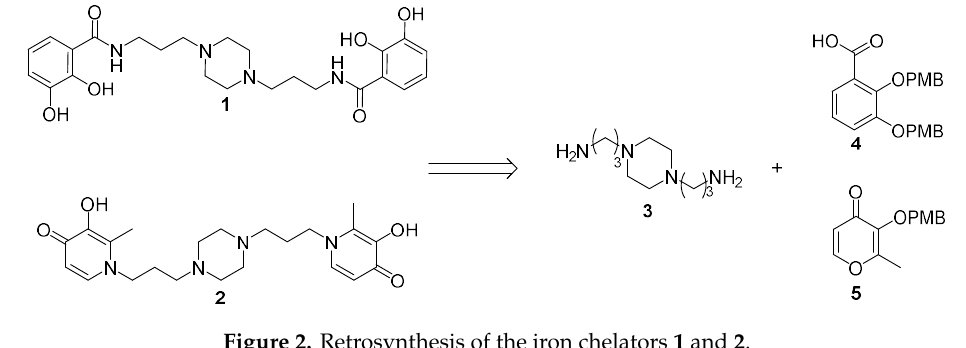
Figure 2. Retrosynthesis of the iron chelators 1 and 2 .